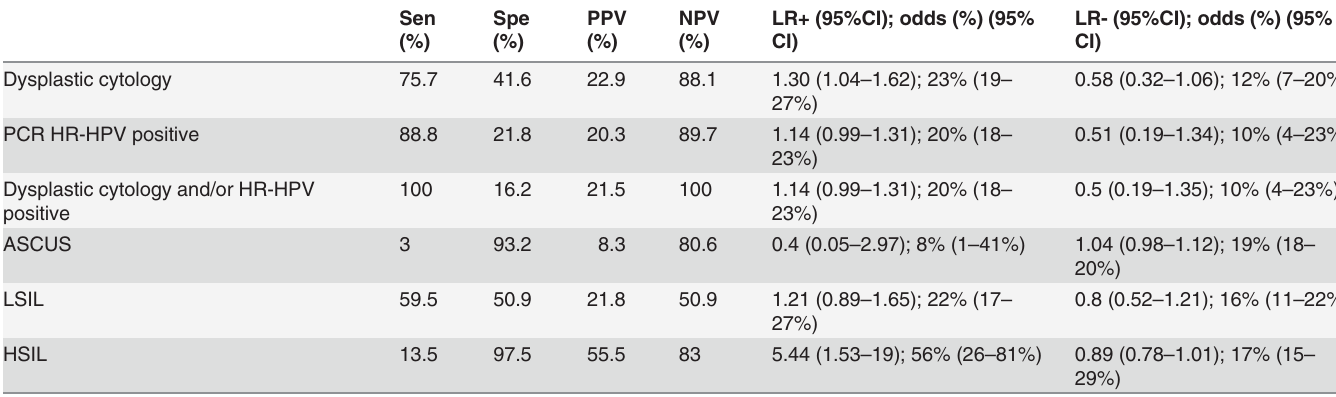
Table 3. Comparison of anal cytology and PCR of HR-HPV in HSIL (AIN2/3) diagnosis.